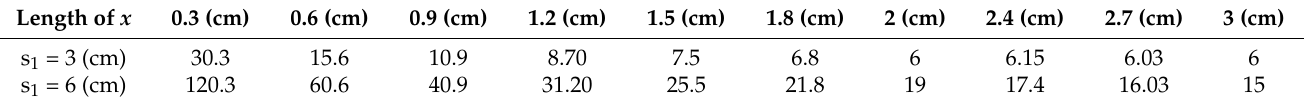
Table 1. DBH measured under different